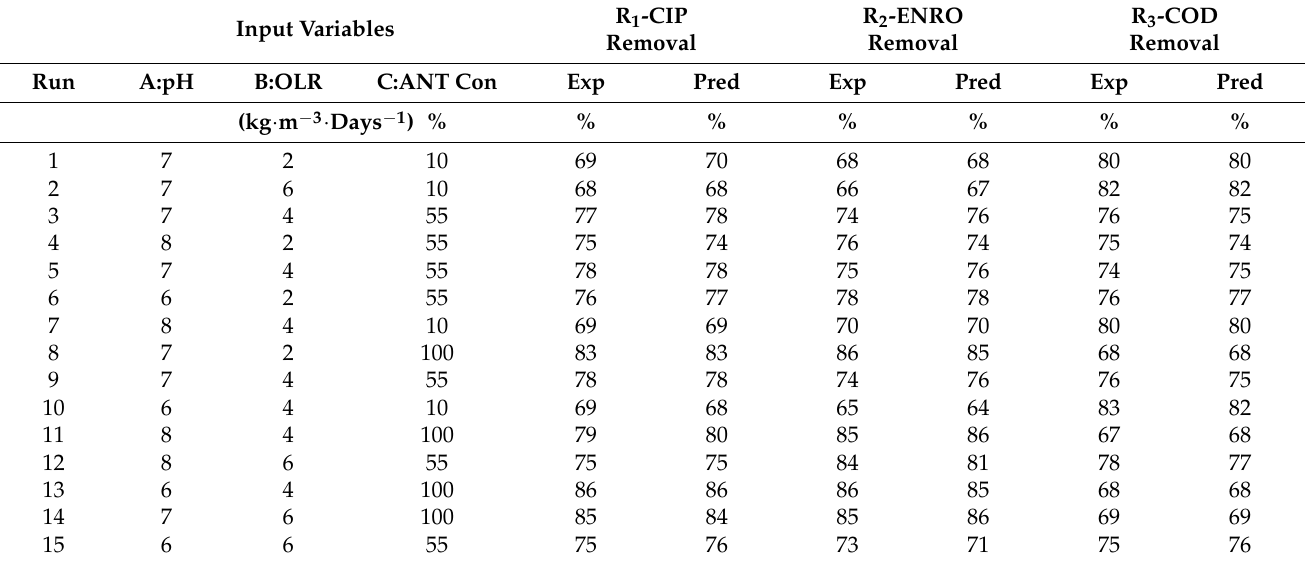
Table 2. Experiment design matrix in actual units and experimental